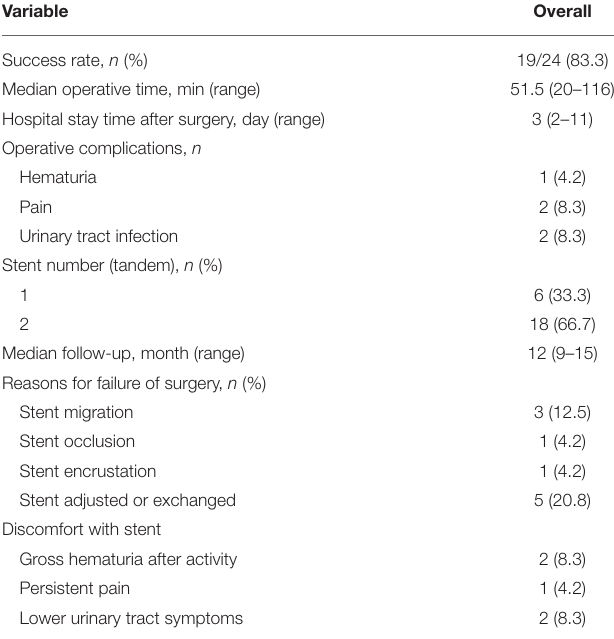
TABLE 2 | Procedure-related characteristics.